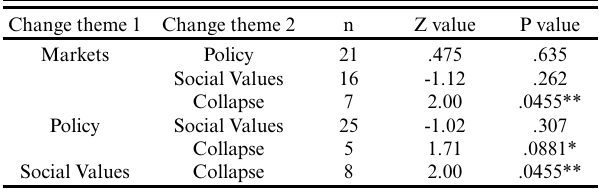
Table 3 . Wilcoxon signed-rank tests comparing differences among change theme weights from Yahara stakeholder